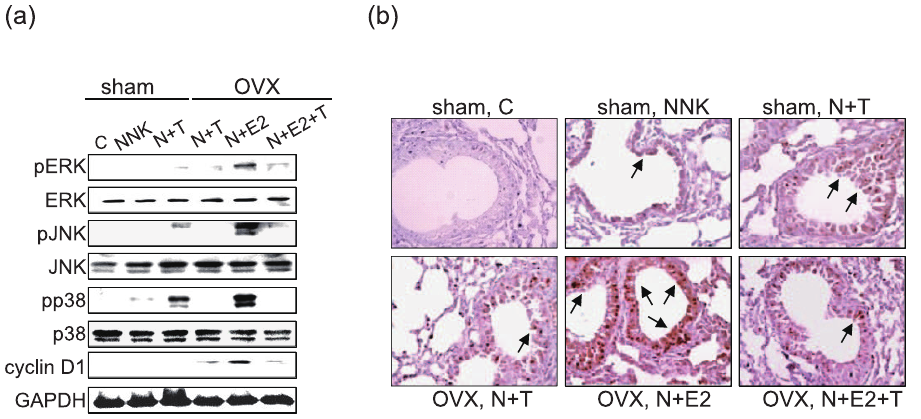
Figure 4. The involvement of the MAPK cascades and the PCNA expression in short-term exposure A/J mice. (a) Lung homogenates were collected from each group of A/J mice. Expression and phosphorylation of pERK, ERK, pJNK, JNK, pp38, p38, cyclin D1, and GAPDH were analyzed by western blot analysis. (b) Immunohistochemistry was used to detect the expression of PCNA (cell proliferation marker) in lung tissues. The arrows indicated positive staining for PCNA in bronchial epithelium (magnification, 6 100). Sham: sham-operated, OVX: ovariectomized, C: